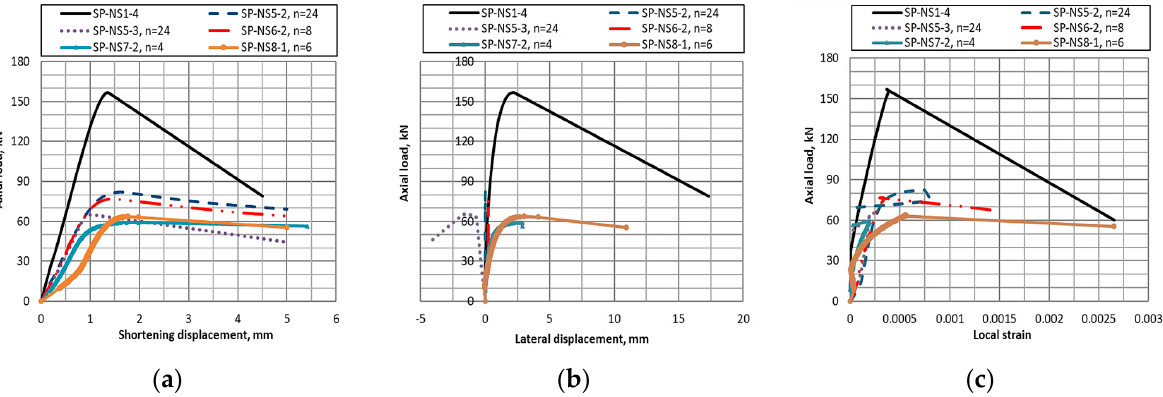
Figure 7. Axial force versus shortening ( a ), lateral displacement ( b ) and local strain ( c ), DoO = 28.30%.